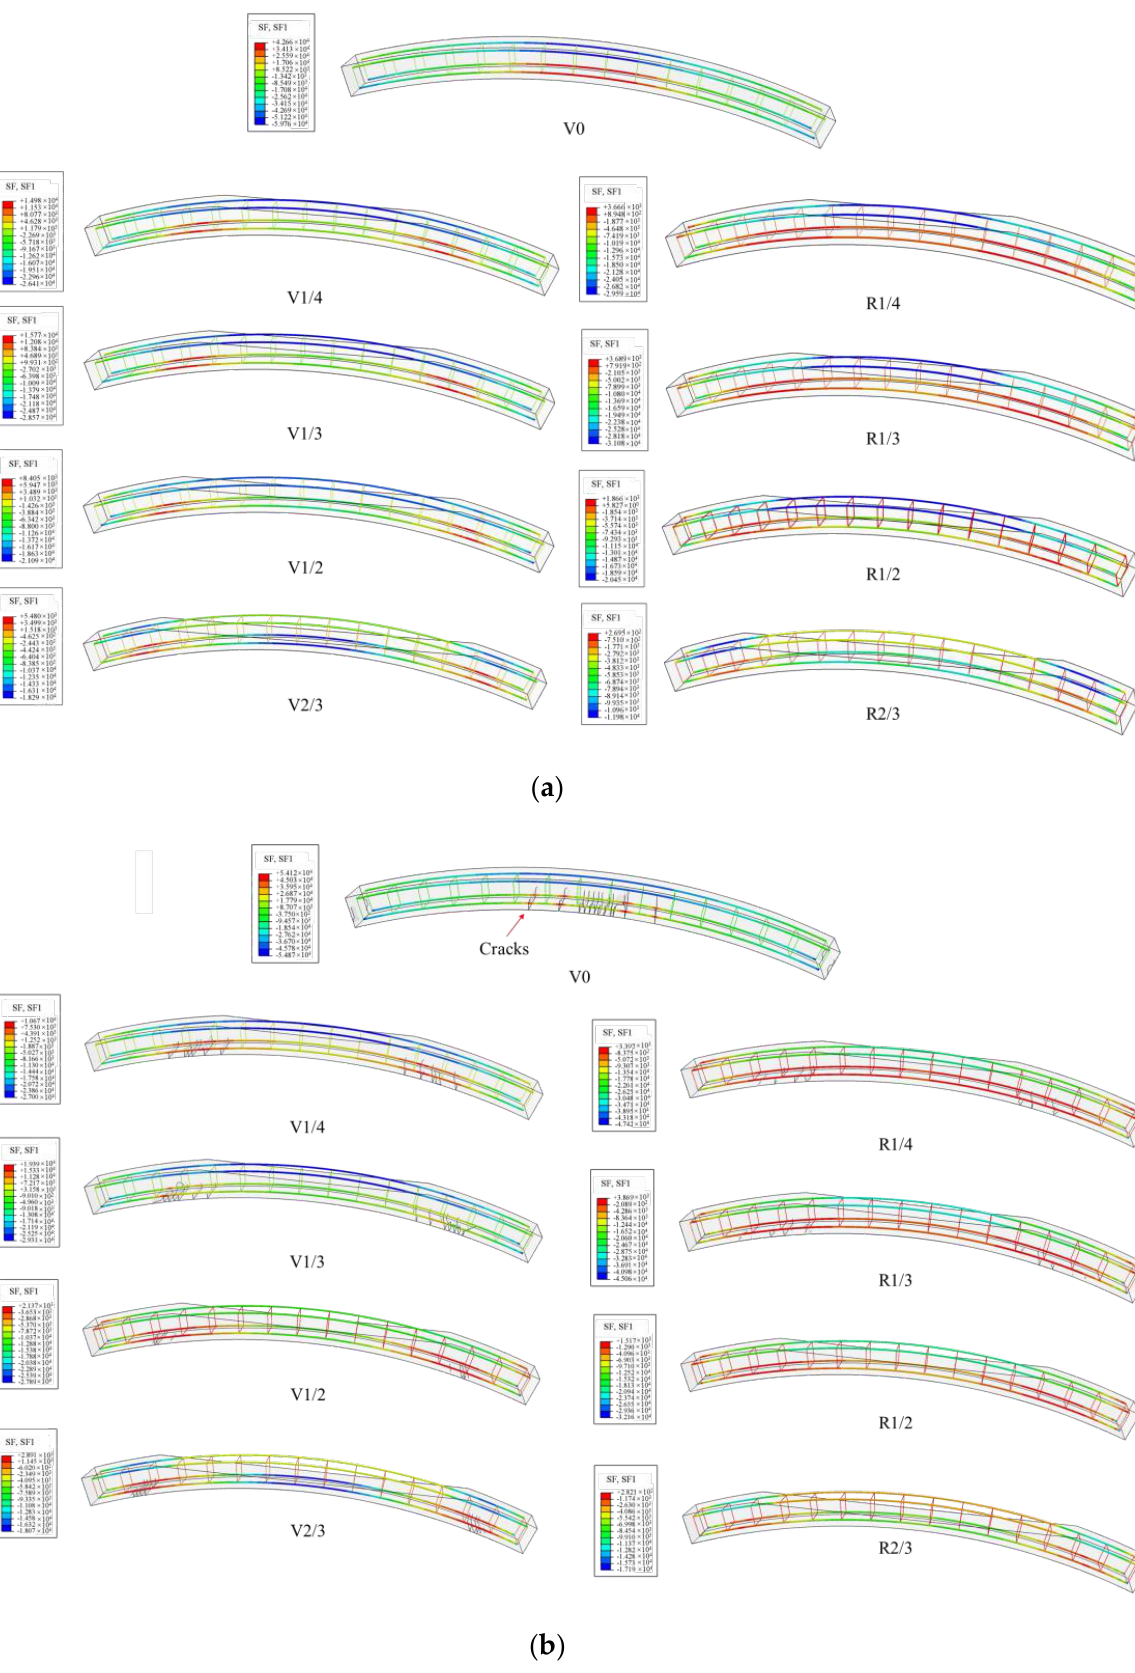
Figure 18. Axial forces of rebars: ( a ) CDP and ( b ) XFEM.